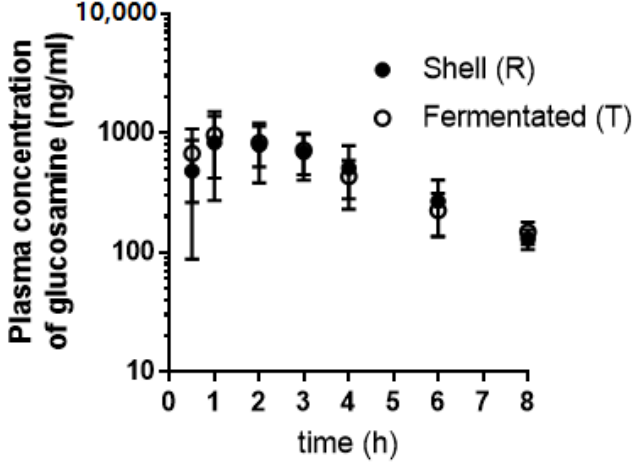
Figure 1. Representative MRM chromatograms of glucosamine in human plasma samples: ( A ) blank plasma; ( B ) blank plasma spiked with LLOQ level of glucosamine (0.1 μg/mL); ( C ) plasma samples at 1 h after an oral administration of 1500 mg of biofermentation-derived glucosamine sulfate 2KCl product to a healthy subject. Determined glucosamine concentration was 0.54 μg/mL. RT means retention time.